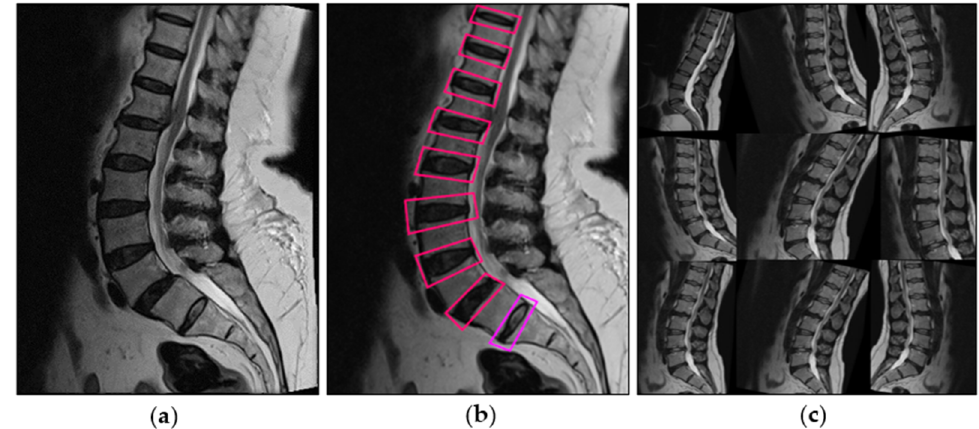
Figure 2. Dataset preparation: sagittal T2-weighted MRI of lumbar spine ( a ), annotation by a radiologist ( b ), image generation augmented by horizontal flip, cropping (zoom 0–20%), rotation (between − 15° and 15°), shear (±15° horizontal and ±15° vertical) ( c ).